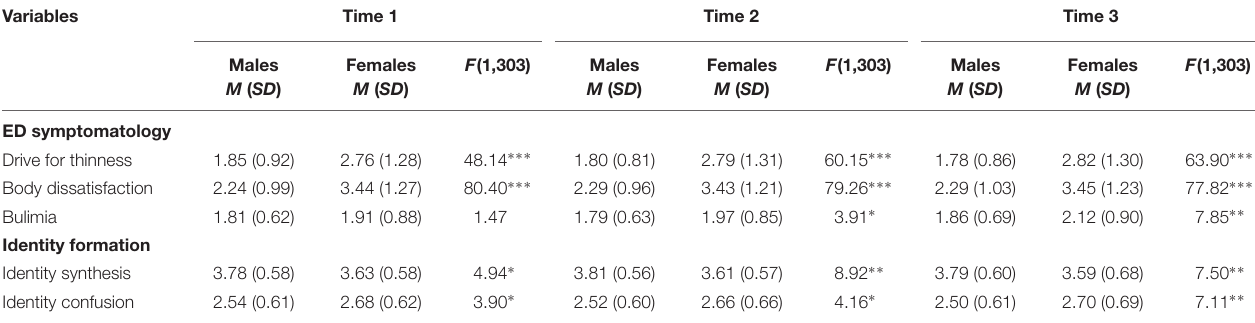
TABLE 1 | Gender distribution of ED symptomatology and identity formation with means, standard deviations, and univariate ANOVAs. Variables